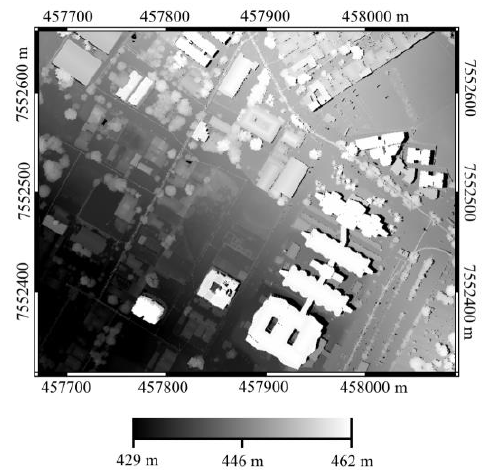
Figure 2. Study area limits in UTM zone 22 S grid